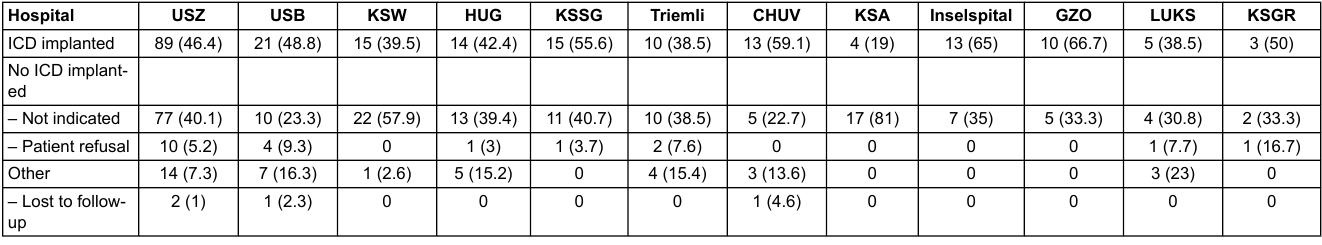
Table 4: Rate of implantable cardioverter defibrillator (ICD) insertion after wearable cardioverter defibrillator (WCD) use.